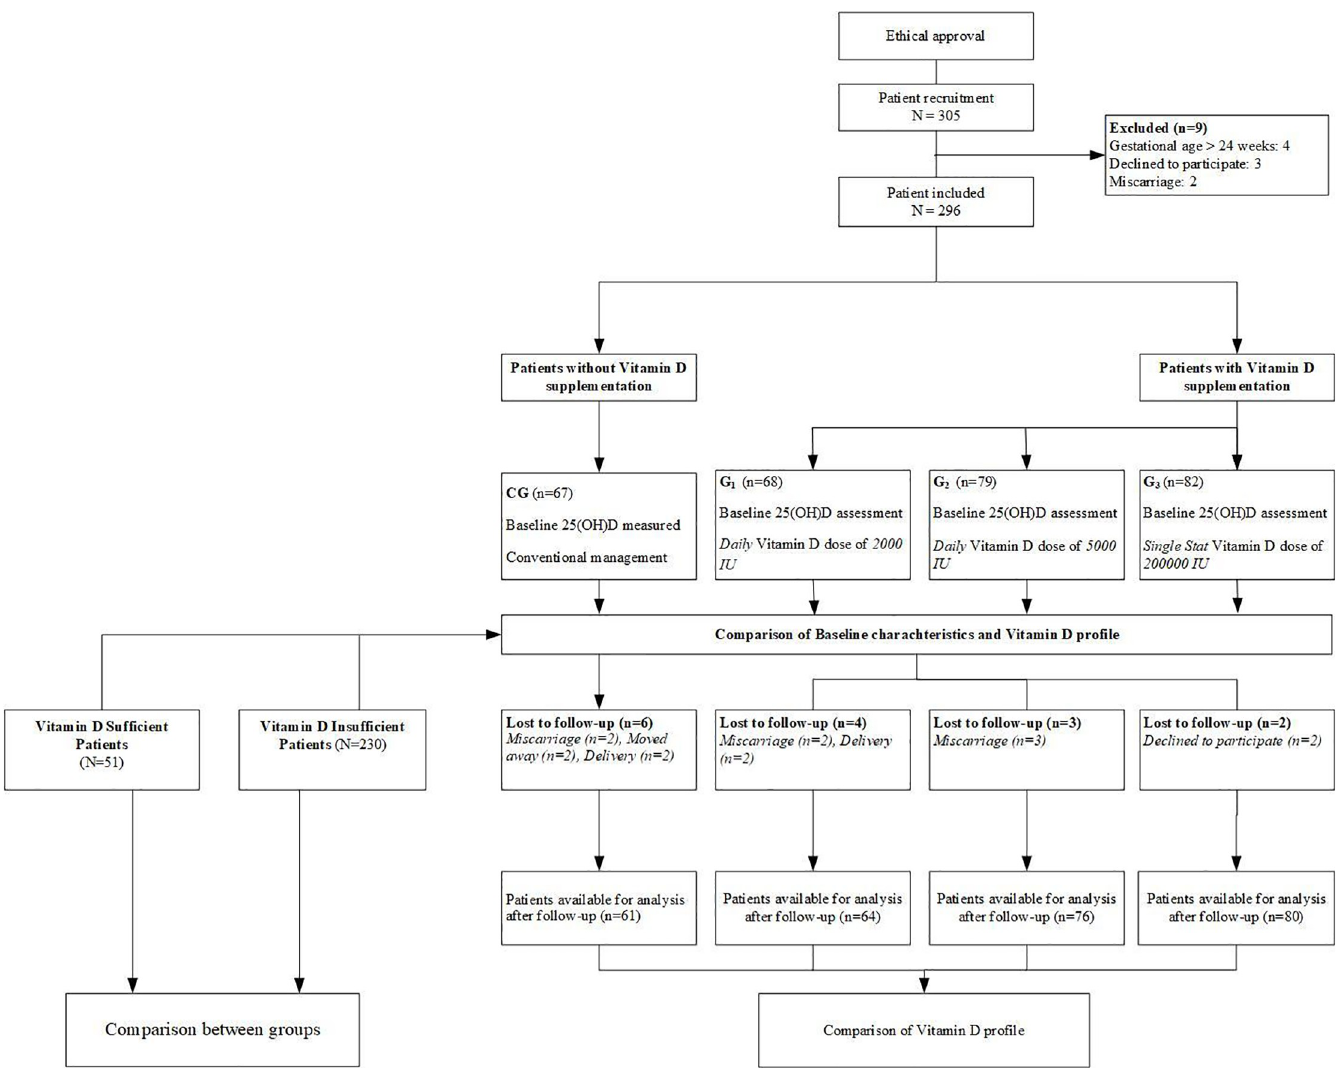
Fig 1. Study flow